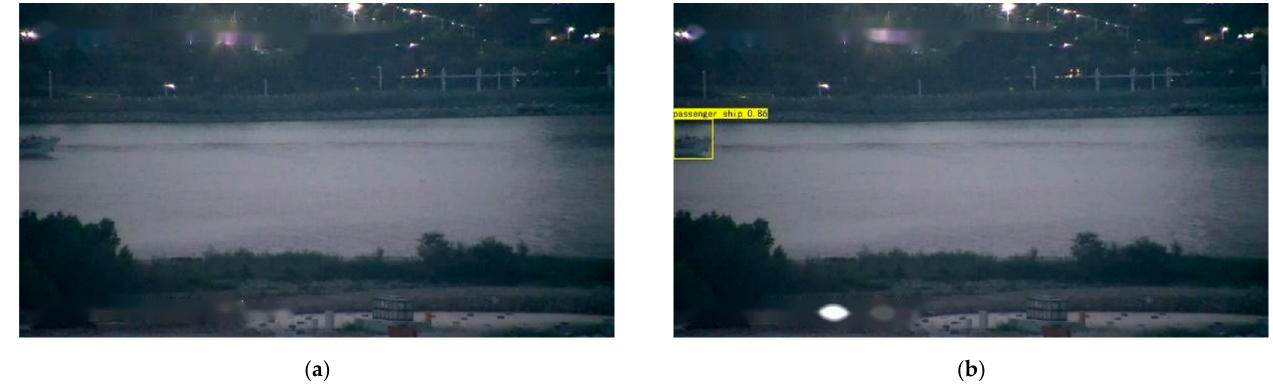
Figure 12. Comparison of small target detection effects under dark and partially occluded conditions.